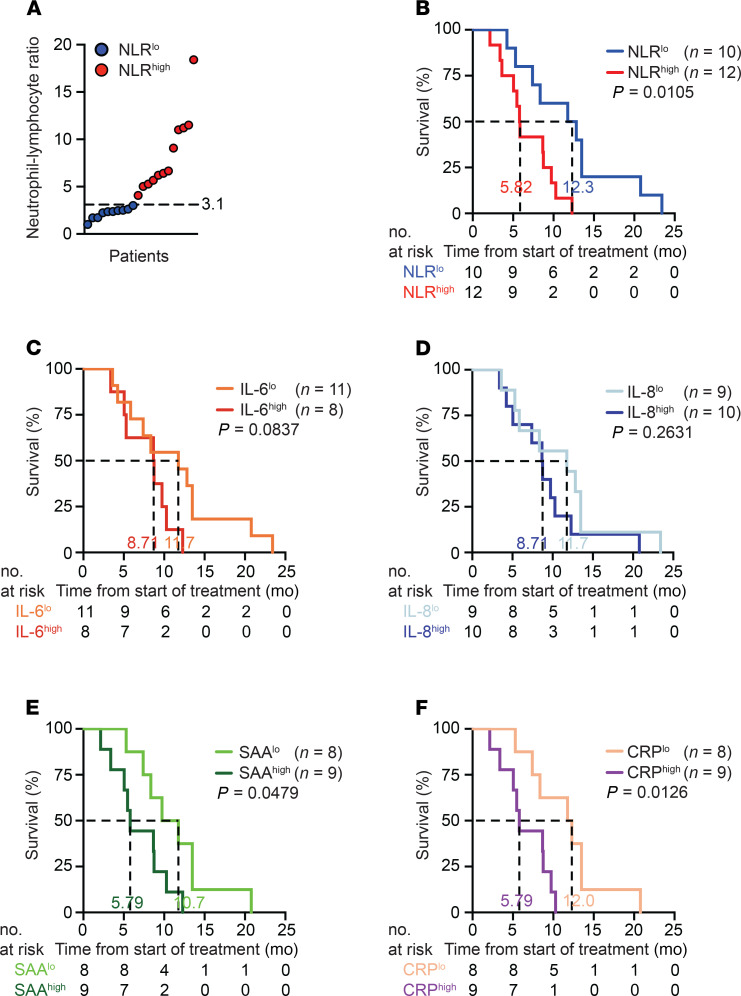
Elevated NLR is associated with poor outcomes in patients with pancreatic ductal adenocarcinoma treated with CD40 agonist–based chemoimmunotherapy.(A) Baseline NLR of individual patients. Dashed line indicates NLR cutoff of 3.1. Patients with NLR > 3.1 were designated as systemically inflamed (NLRhi) and patients with NLR < 3.1 were designated as noninflamed (NLRlo). (B) OS was estimated by Kaplan-Meier methodology and log-rank test was used to determine significance. (C–F) Univariate survival analysis using plasma (D) IL-6 median cutoff of 5 pg/mL, (D) IL-8 median cutoff of 14 pg/mL, (E) SAA median cutoff of 130 μg/mL, and (F) CRP median cutoff of 14.3 mg/L. Numbers indicate median OS.